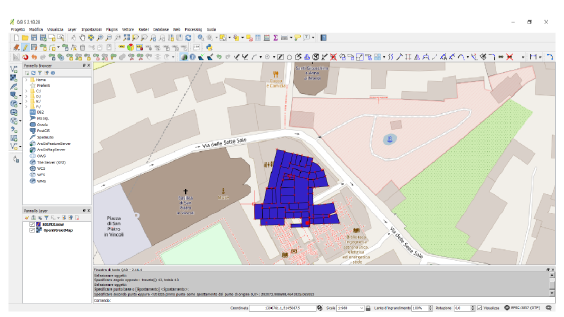
Figure 4. Attribute table of the first floor of of one building of the Civil and Industrial Engegnering faculty.